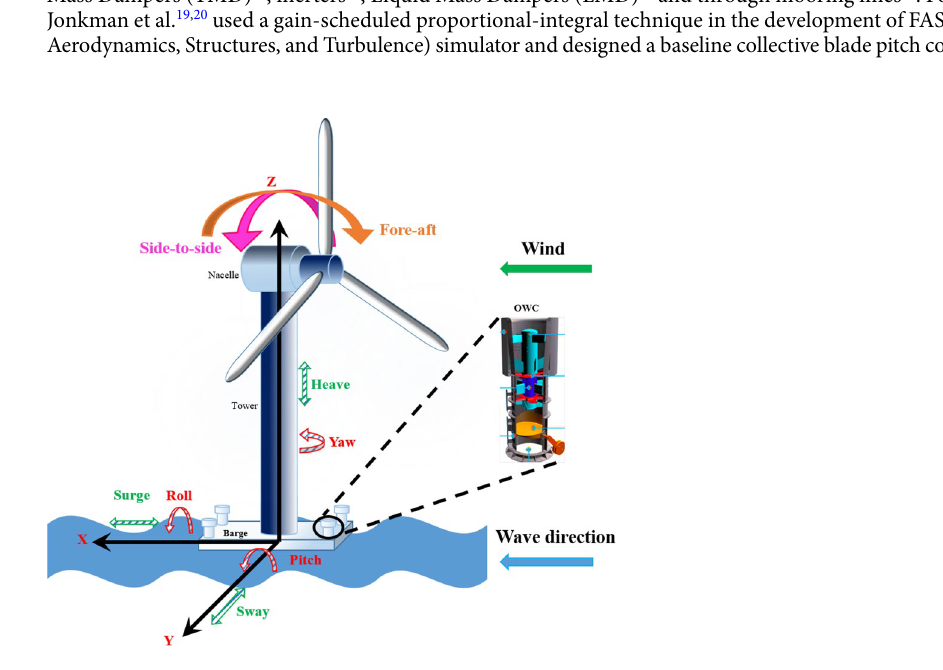
Figure 2. Barge-based floating offshore wind turbine with four